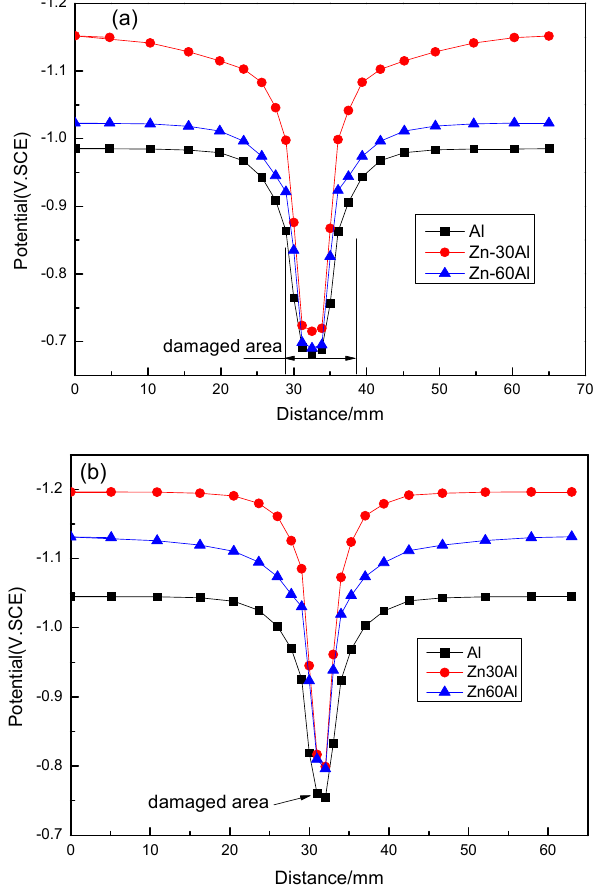
Figure 8. The potential distribution on different cold-sprayed AlZn coatings with different damaged areas after 2 h immersion along the sample: ( a ) coatings with 10 mm damaged area; ( b ) coatings with 1 mm damaged area. SCE: saturated calomel electrode.